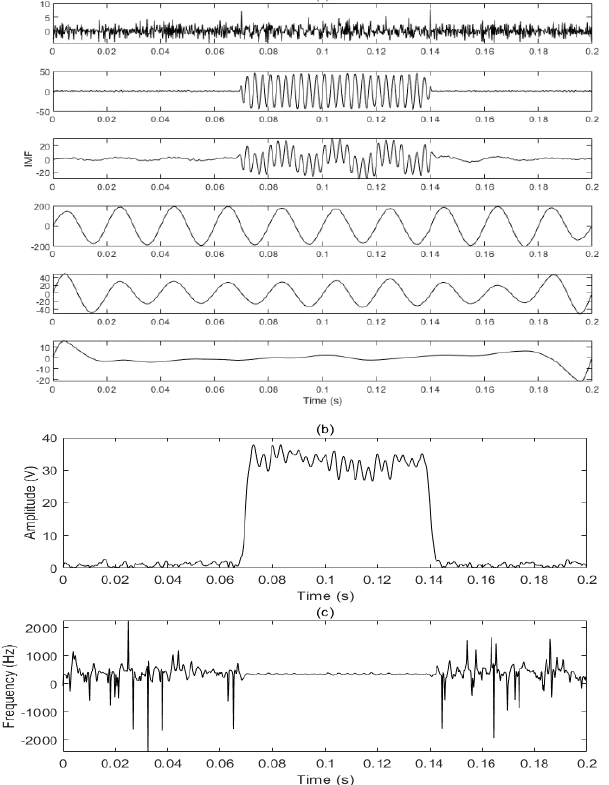
Figure 18. Oscillatory transient IMF components ( a ), amplitude ( b ), and frequency ( c ).